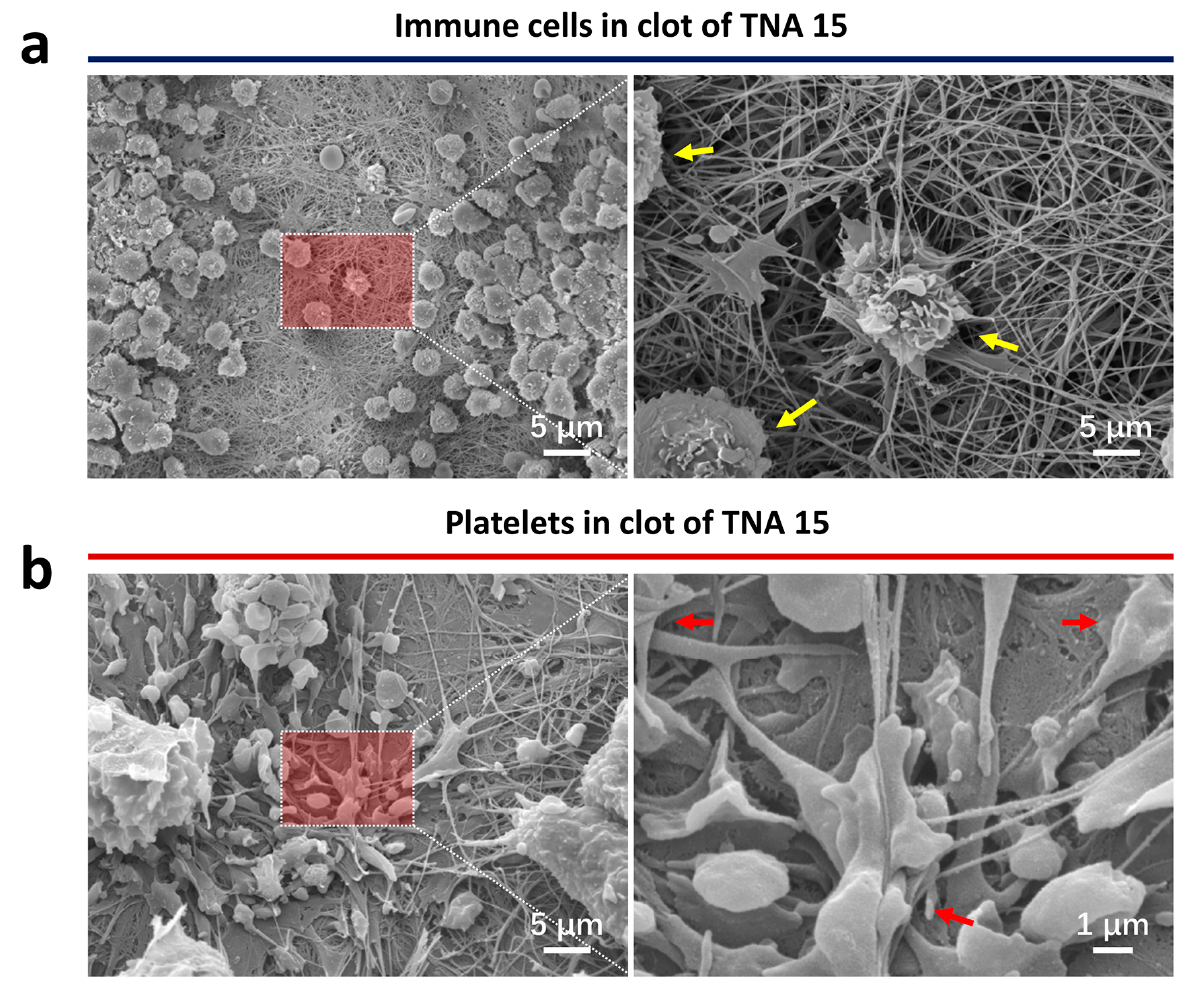
Figure 2. ( a ) SEM images of the immune cell (yellow arrows) morphology within the clot on the specimens. ( b ) SEM images of the platelet activations (red arrows) within the clot on the specimens. The right image is magnified from the left one.